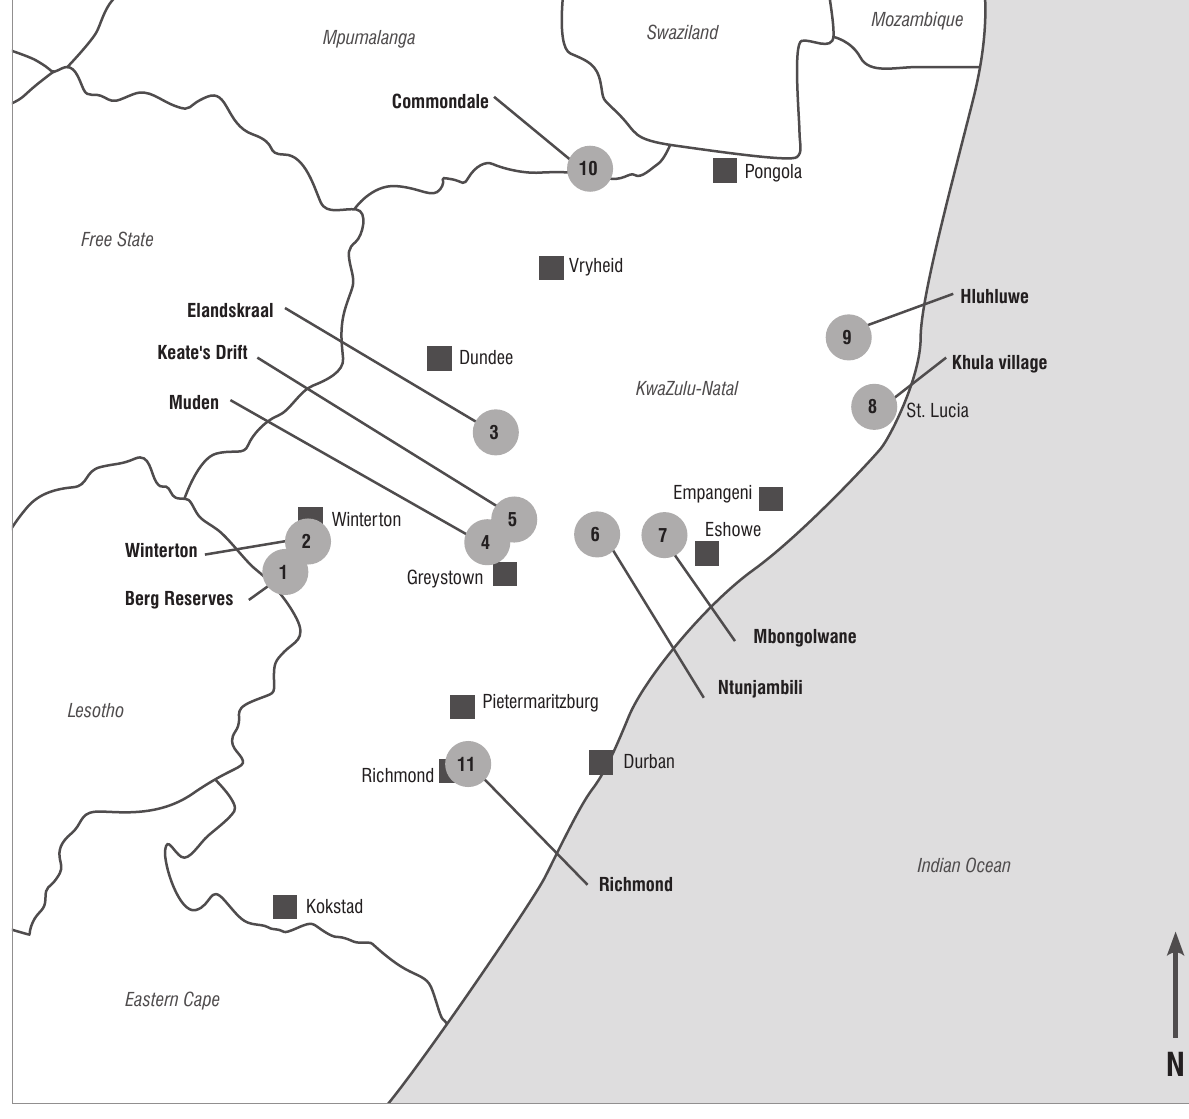
Figure 1: Localities of survey sites. Provinces and neighbouring countries are shown in grey italics; ■ = towns; ○ = survey sites, numbered and shown in bold. Exact latitudes and longitudes of the interview sites are provided in the